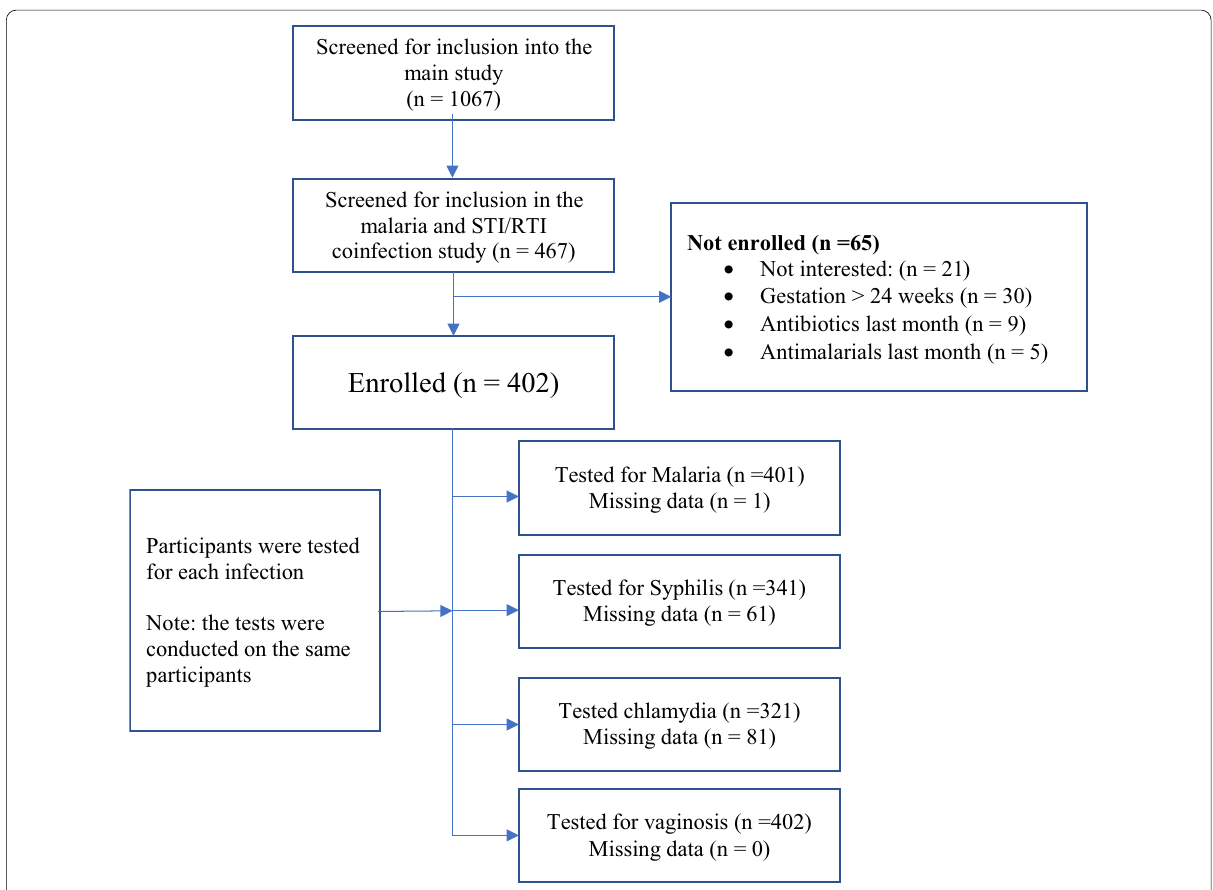
Fig. 1 Pregnant women participants’ flow chart. STI/ RTI: sexually transmitted /reproductive tract